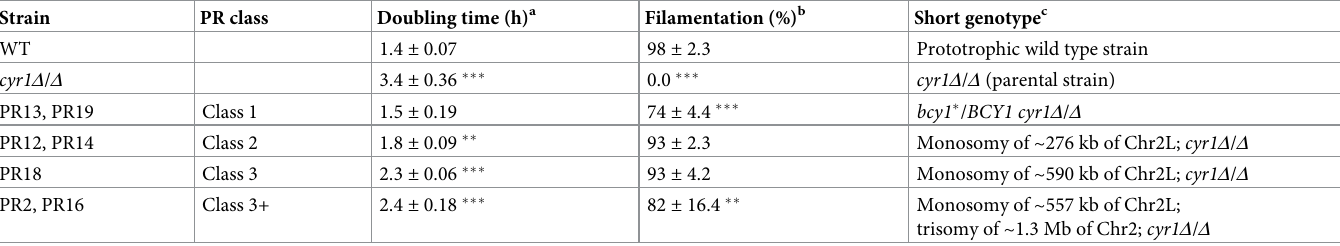
Table 1. Phenotypic and genetic variations of cyr1 Δ / Δ pseudorevertants (PRs).